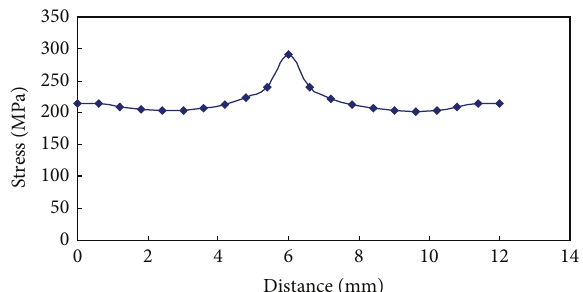
Figure 8: The stress of node on the intersecting lines between 𝑋 - 𝑍 plane and cavity, 𝐿/𝑅 =